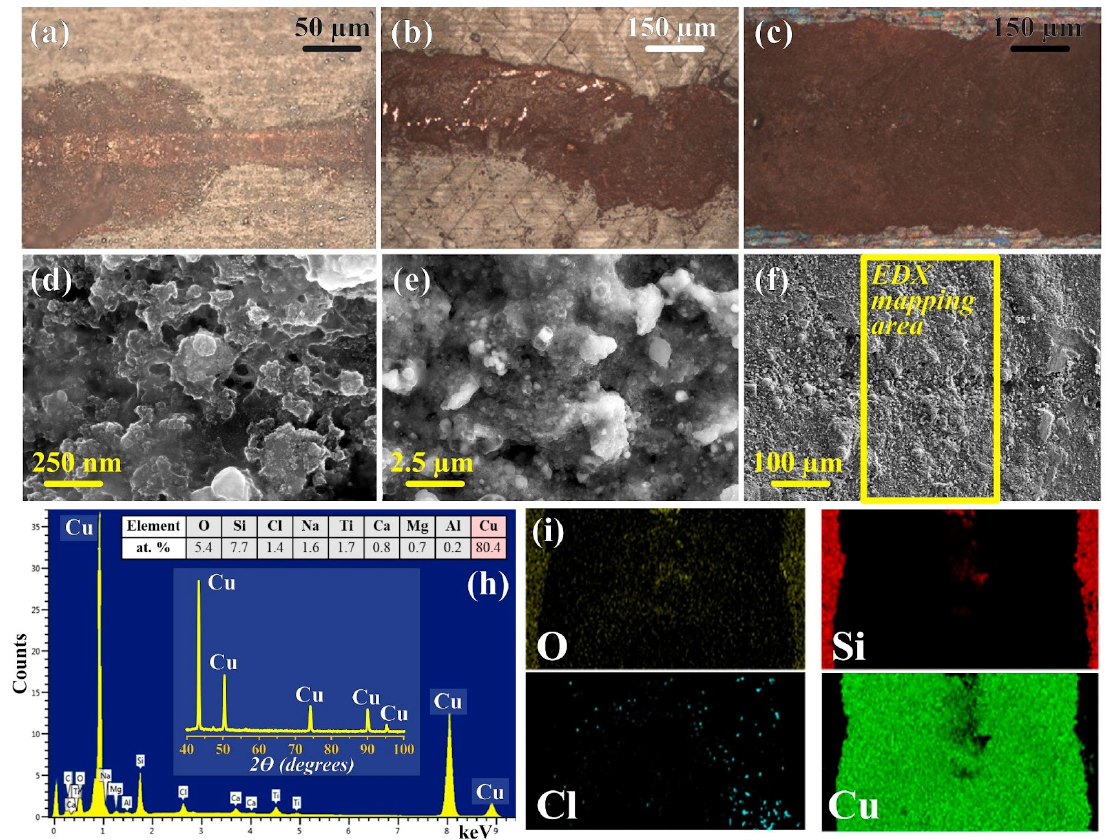
Figure 2. Morphology of copper tracks on ( a ) the original (non-treated substrate, type I), ( b ) laser-treated and laser-cleaned substrate (type II), and ( c ) laser-treated and non-cleaned substrate (type III). SEM images of different resolution ( d – f ), and XRD pattern and EDX mapping ( h – i ) of the track presented on the image ( c ). Laser deposition processing parameters: f = 20 kHz, τ = 200 ns; ( а ): V = 0.05 mm/s, P = 1.31 W; ( b , c ): V = 0.5 mm/s, P = 3.1 W.